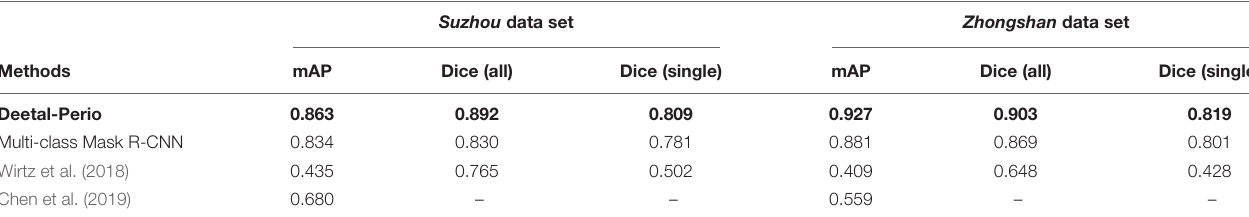
TABLE 1 | Performance comparison tested on the Suzhou data set and Zhongshan data set between Deetal-Perio and other methods on teeth numbering/segmentation task, by mAP, Dice (all) and Dice